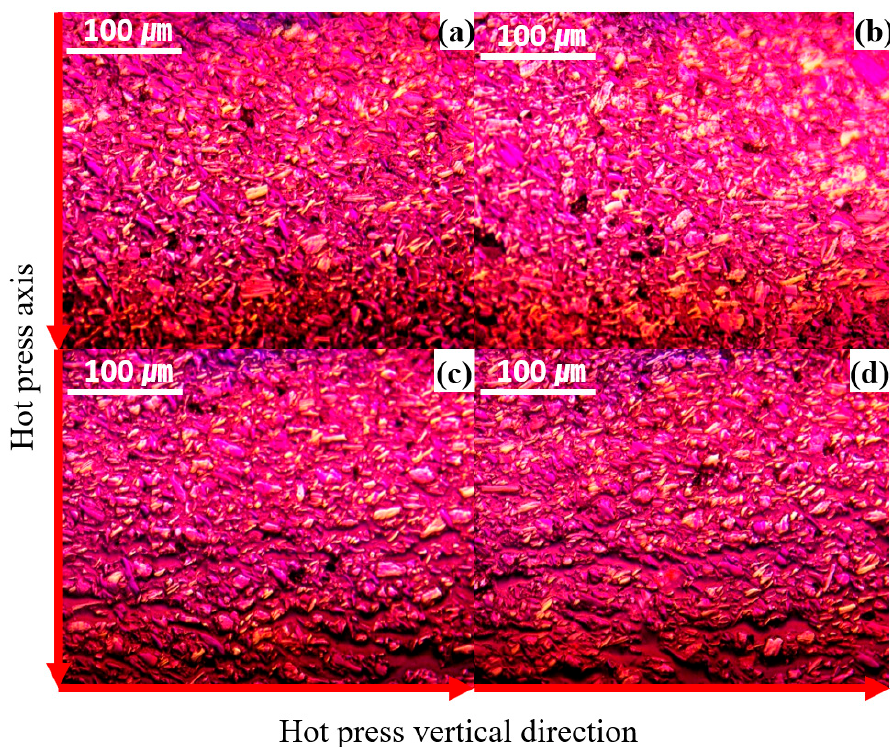
Figure 2. Optical structure of green block: ( a ) B_N, ( b ) B_5, ( c ) B_10, ( d ) B_20.